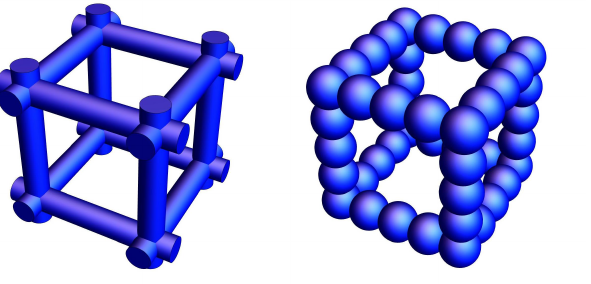
Figure 2. Scheme of possible edges of simple cubic boxes making a porous body. The cylinder in the left upper corner is replaced by string of spheres with increasing overlap to the right bottom